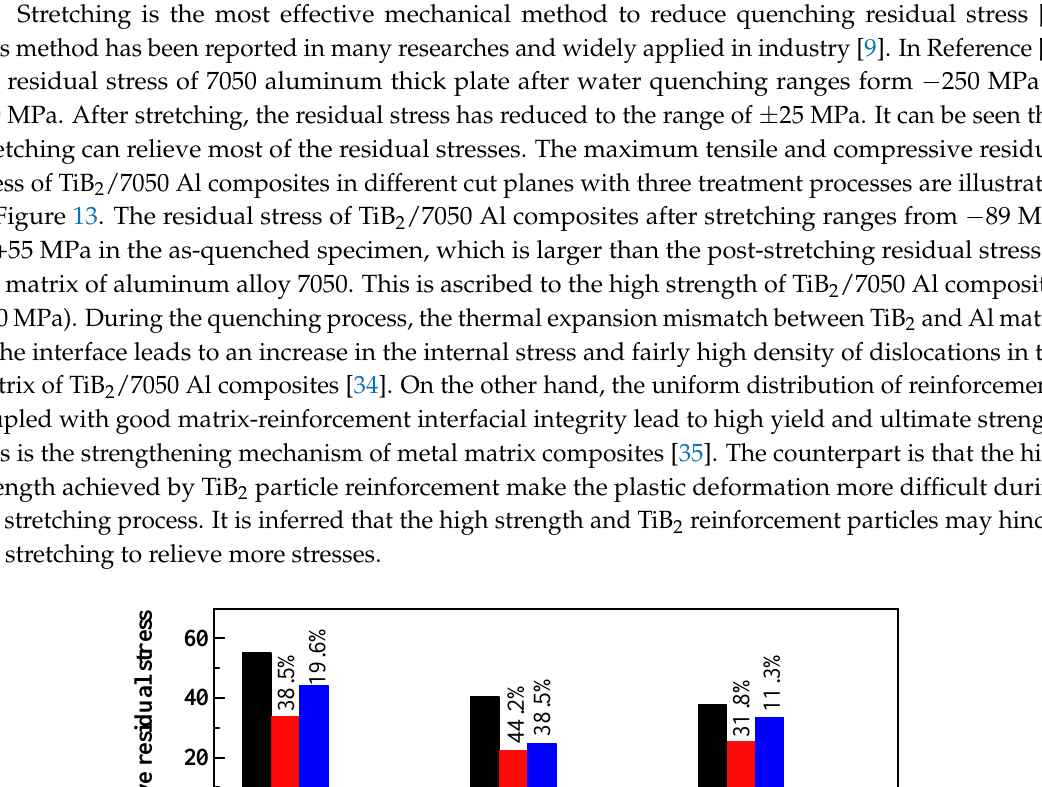
Figure 14. Average tensile (+) and compressive (−) residual stress in different cut planes with three treatment processes. The percentage means the maximum stress reduction of heat and cold post- treatment compared with as-quenched specimen.